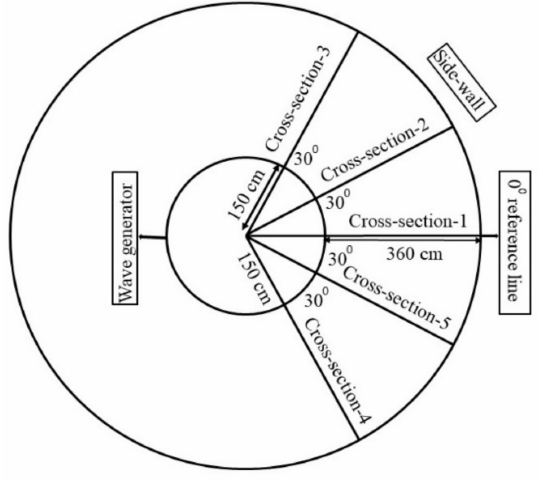
Figure 3. Cross-sectional measurements at five